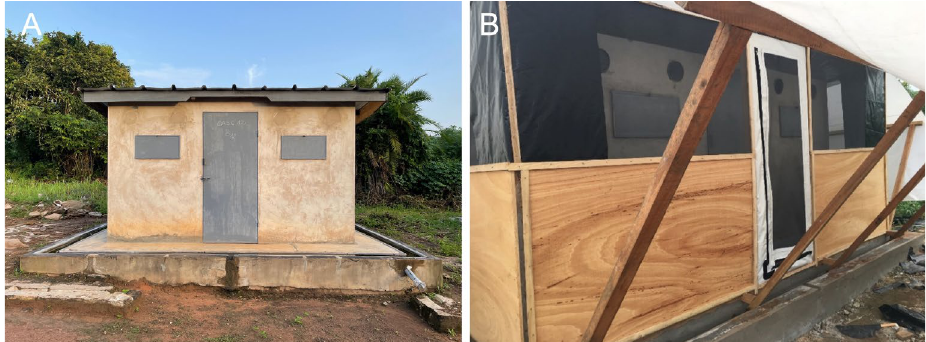
Figure 1. ( A ) West African experimental hut style at the M’Be rice field, central Côte d’Ivoire, ( B ) West African experimental hut fitted with eave tubes and surrounded with an